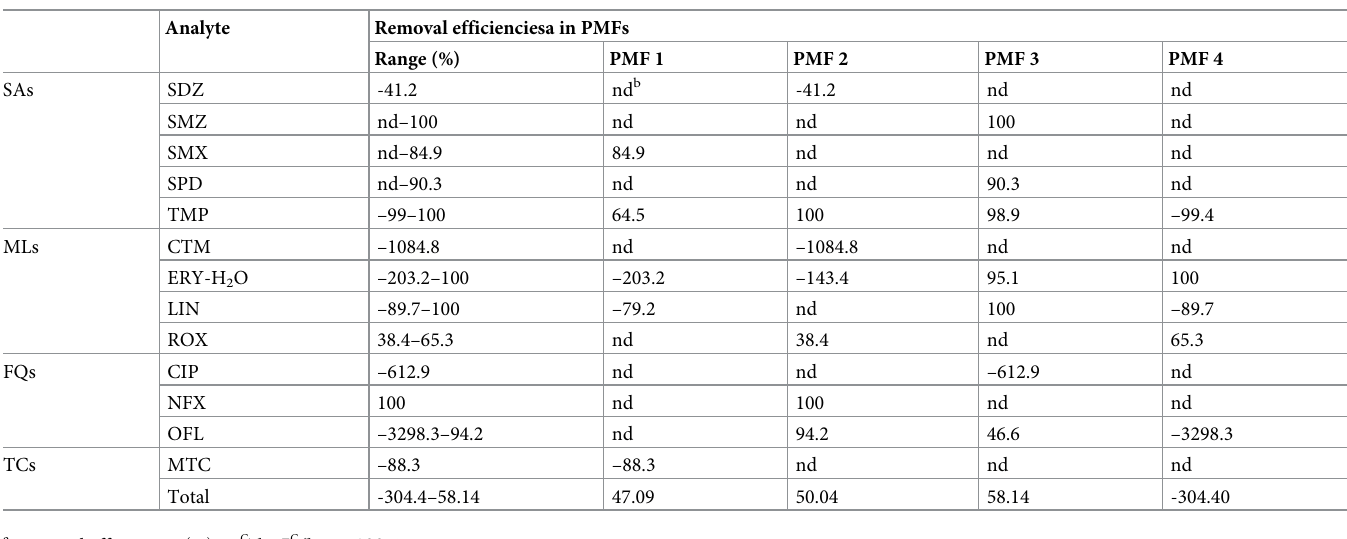
Table 3. Overall removal efficiencies of the detected antibiotics in the